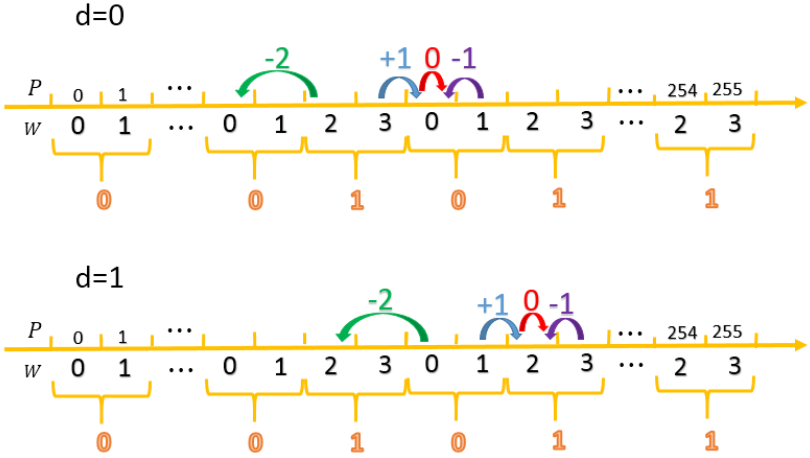
Figure 7. Illustration of incremental value ∆ for different situations.